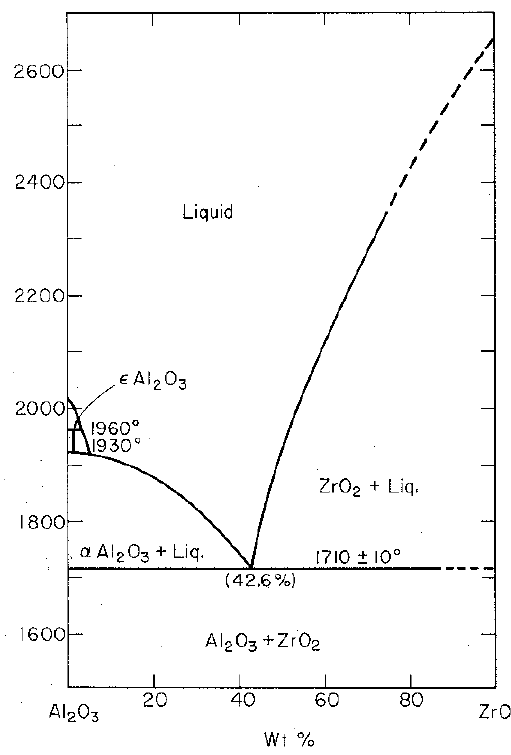
Figure 25. Phase diagram of the system alumina-zirconia.